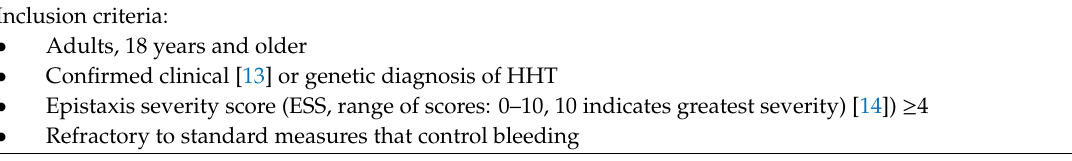
Table 1. Inclusion and exclusion